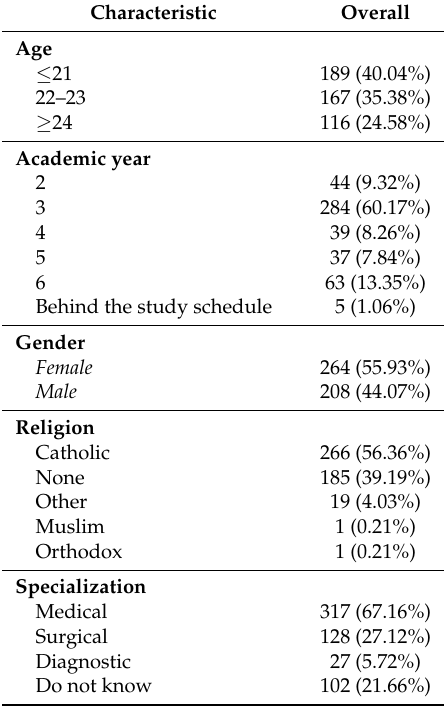
Table 1. Social and demographic characteristics of study participants. The results are expressed as means with standard deviations or as numbers of subjects with